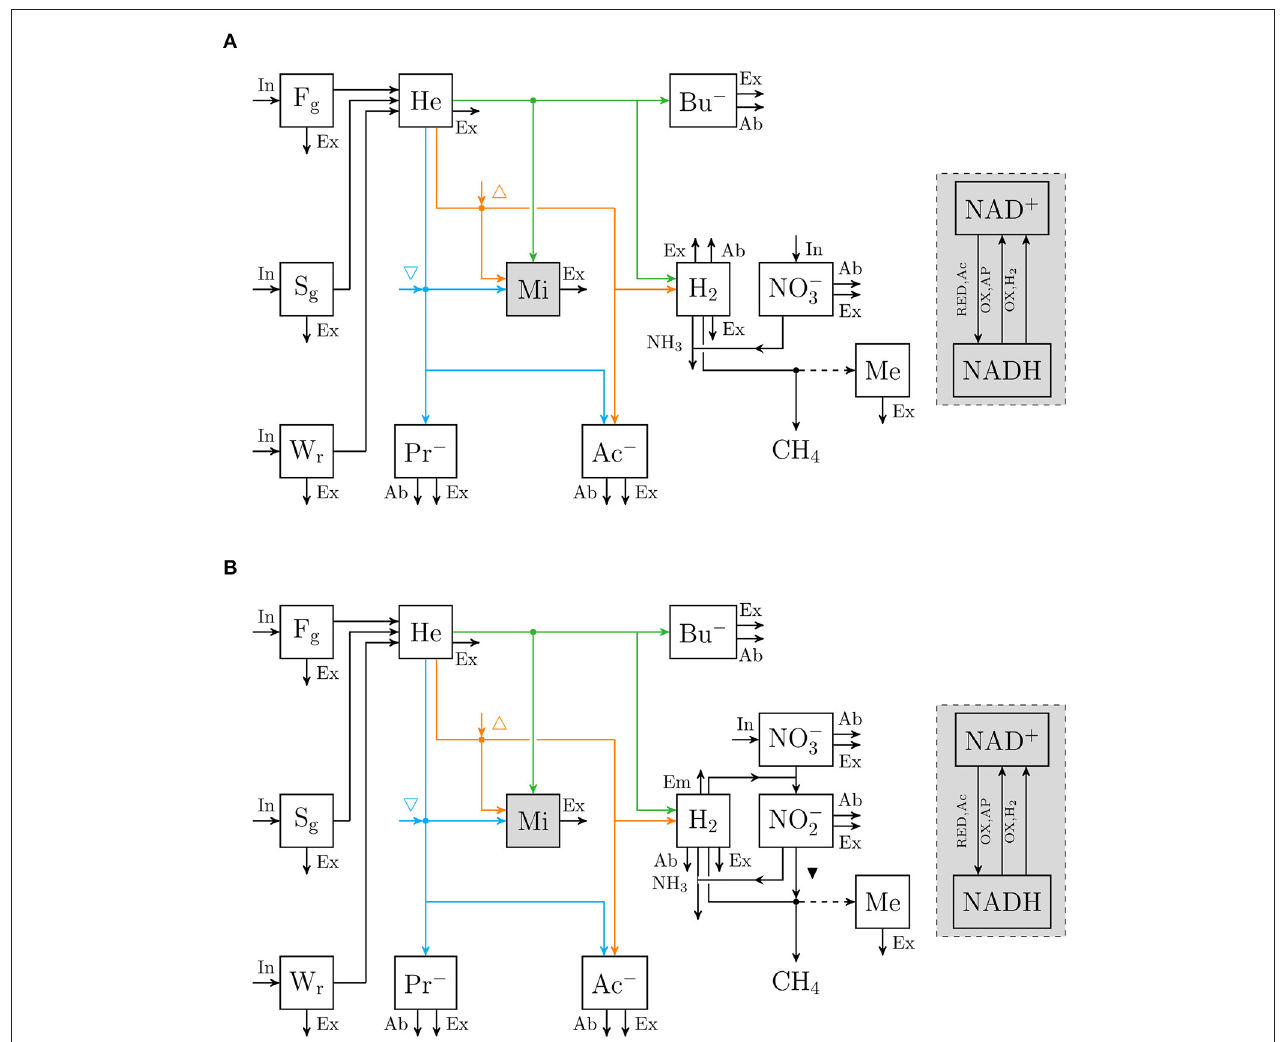
FIGURE 2 | Flow chart that conceptually represent (A) the rumen nitrate simple model, and (B) the rumen nitrate+nitrite model. Boxes enclosed by solid lines represent state variables (with NO – 3 for nitrate [mol] and NO – 2 for nitrite [mol]; H indicates inhibition of methanogenesis; other abbreviations are described in Figure 1 ), dots indicate microbial